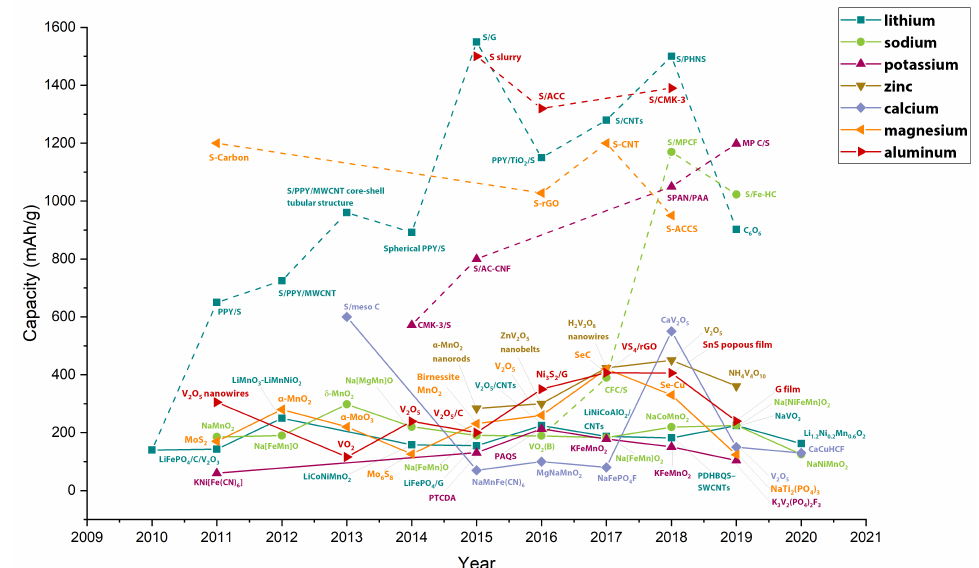
Figure 11. The advance of the cathodes’ specific capacity, comparing the seven battery types: Li, Na, K, Zn, Ca, Mg, and Al. Continuous line: traditional intercalation materials. Dot lines